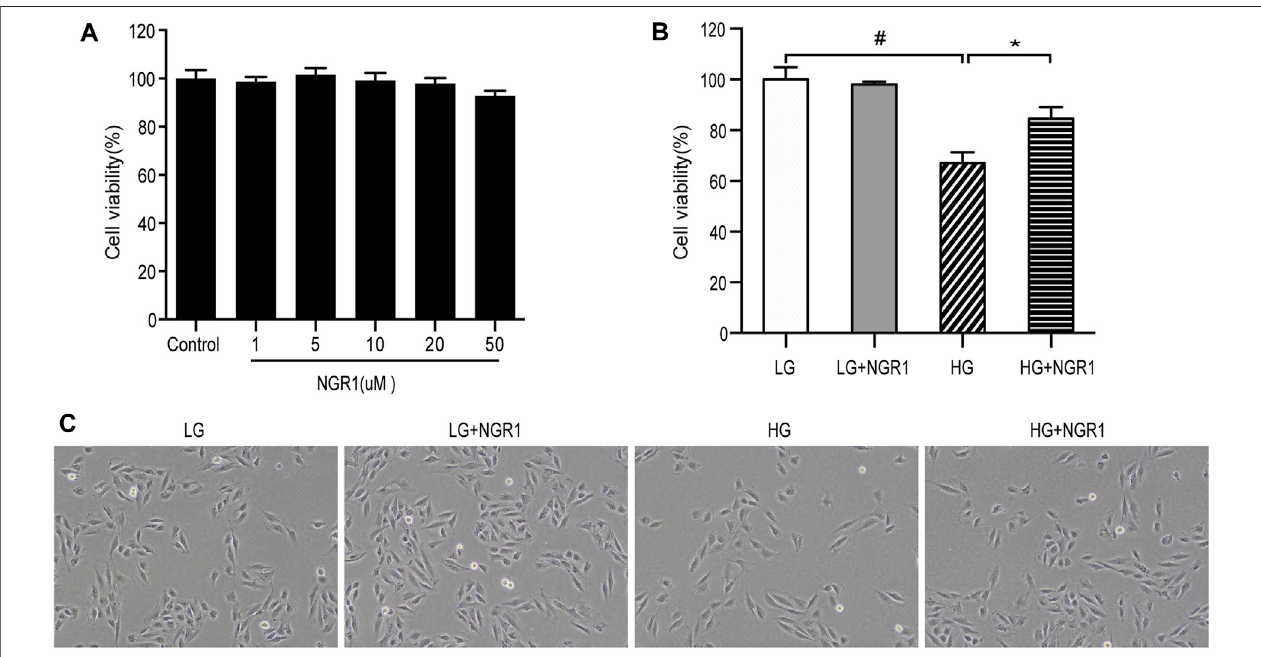
FIGURE 1 | NGR1 protected H9c2 cardiomyocytes from high glucose-induced cell death. (A) Effect of NGR1 on H9c2 cardiomyocyte viability, which was insigni fi cant at concentrations up to 50 μ M. (B) Cell viability decreased when treated with HG, but NGR1 reversed the effect of HG on cell viability. (C) Characteristic cell morphological changes at × 100 magni fi cation. The cells swelled and became longer, but these morphological changes were abolished after treatment with NGR1. The data are represented as mean ± SEM, n (cid:2) 3 for each group. * p < 0.001 and # p < 0.001. LG, 5.5 mM glucose; HG, 30 mM glucose; NGR1, Notoginsenoside R1.